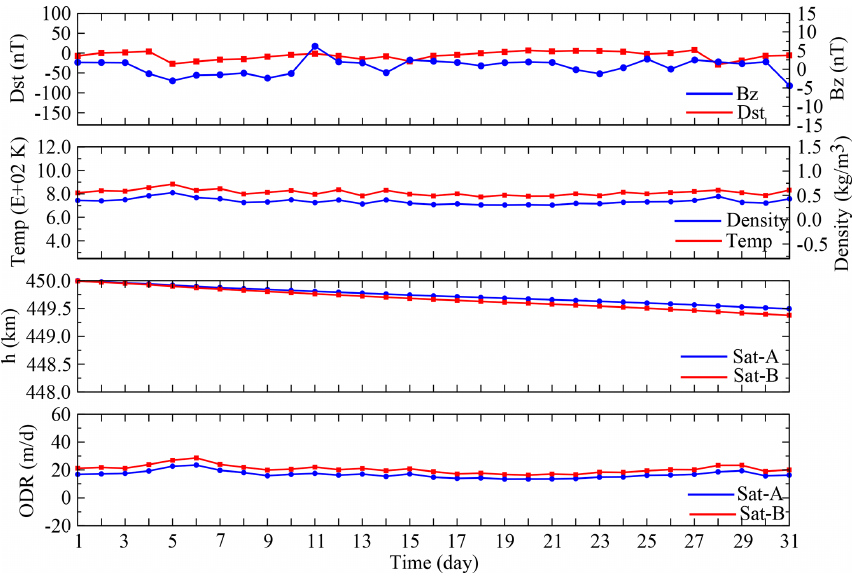
Figure 5. Mean daily variations in Dst, B z , ρ , T , h and ODR for Sat-A (blue) and Sat-B (red) for quiet conditions (July 2006).